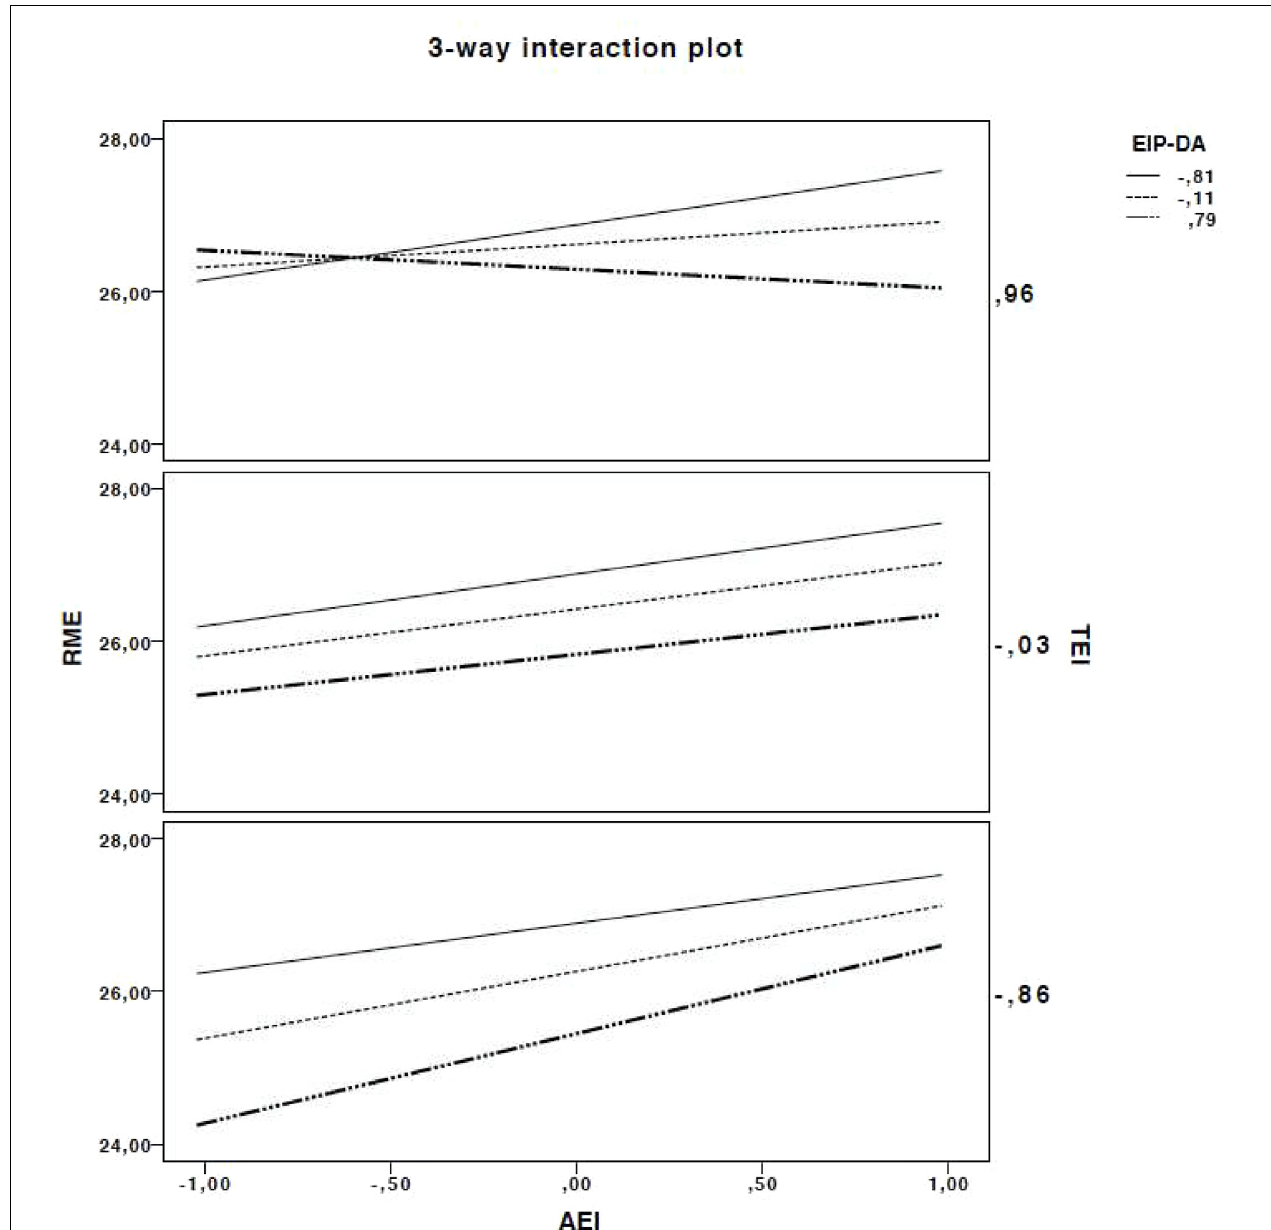
FIGURE 2 | Three-way interaction plot of AEI, TEI, and EIP-DA RME ( N = 324). AEI, ability emotional intelligence; TEI, trait emotional intelligence; EIP-DA, emotional information processing—difficulties in maintaining focalized attention; RME, Reading the Mind in the Eyes.